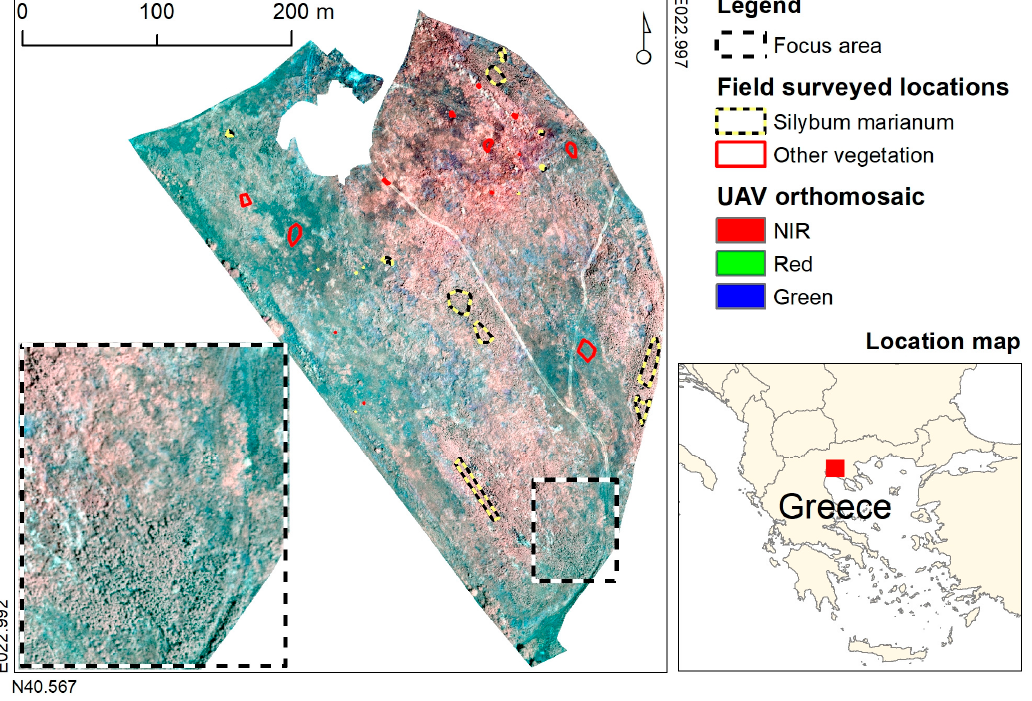
Figure 1. Study area, UAV orthomosaic, focus area, and field surveyed locations.